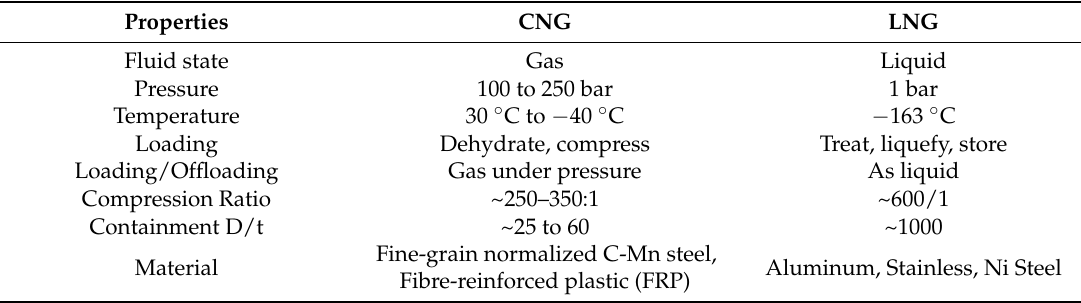
Table 9. Differences between compressed natural gas (CNG) and LNG